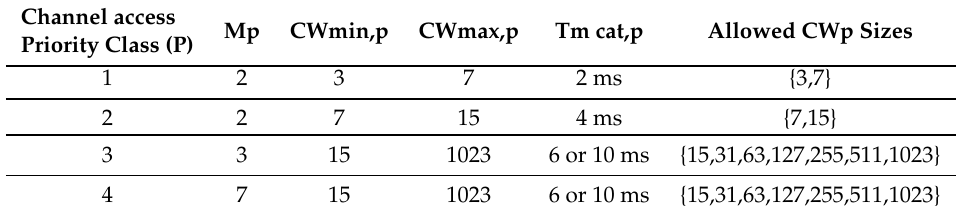
Table 6. Channel access priority of